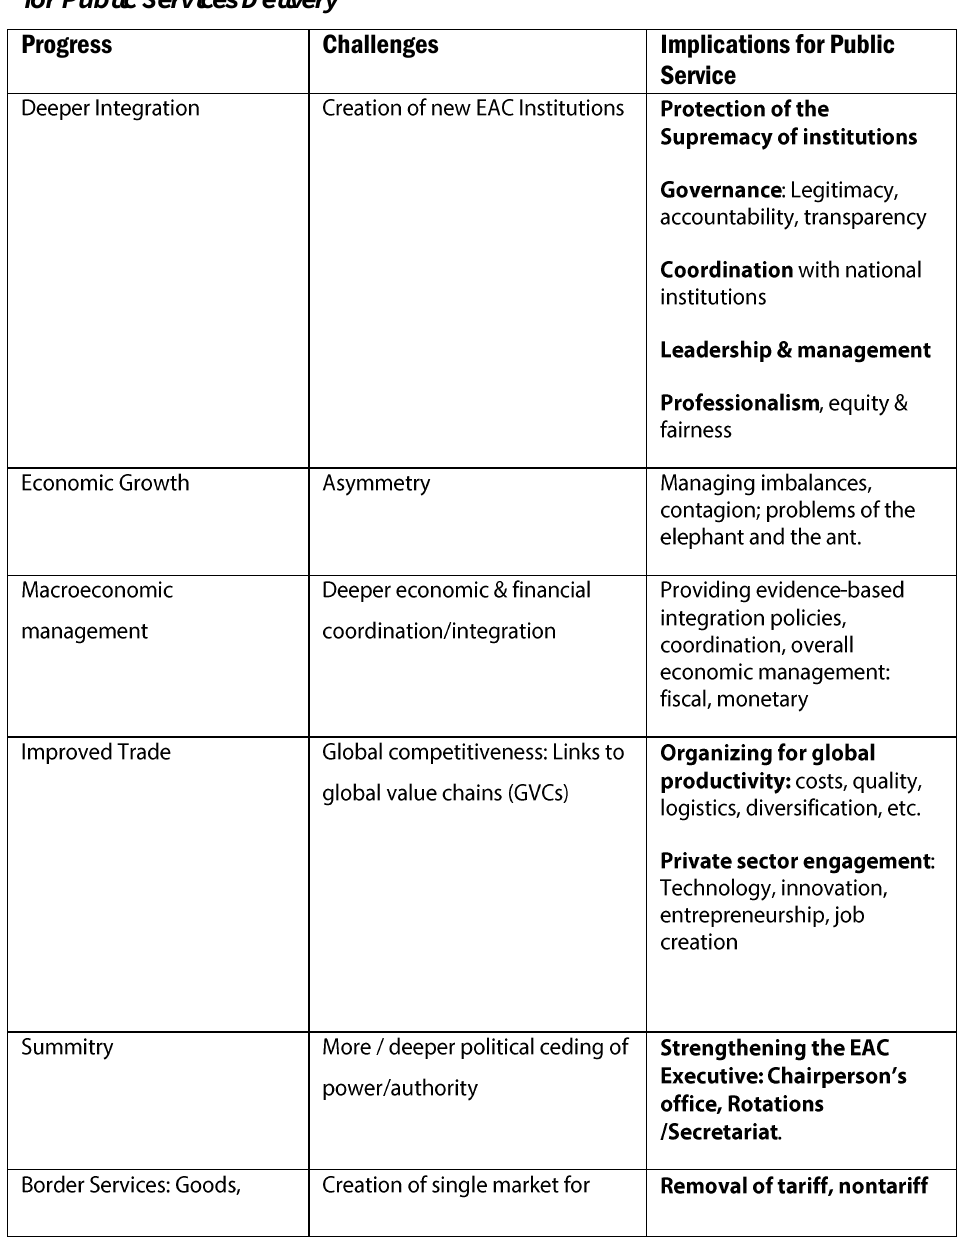
Table 3: The East African Community: Progress, Challenges and